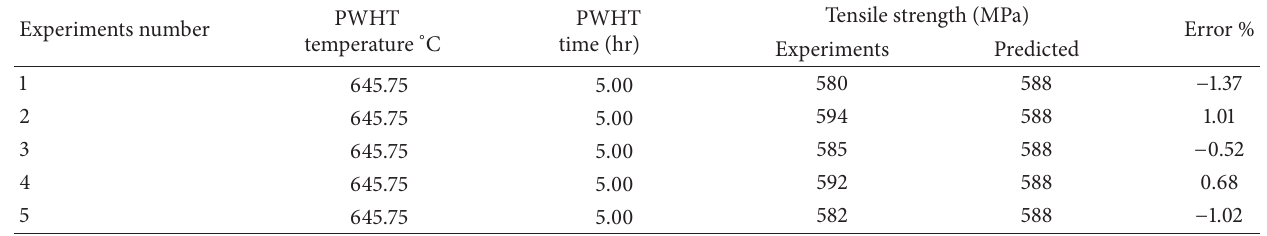
Table 8: Validation model experiments: comparisons with the predicted values.